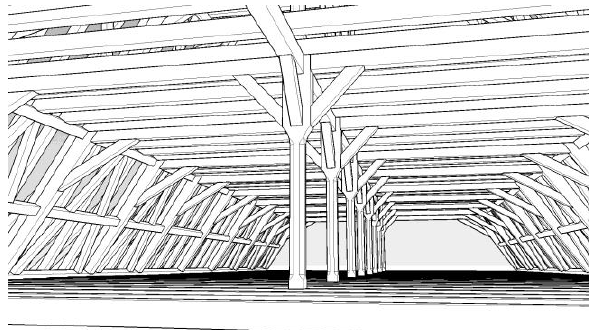
Figures 9e: Details of the 1 st level of the